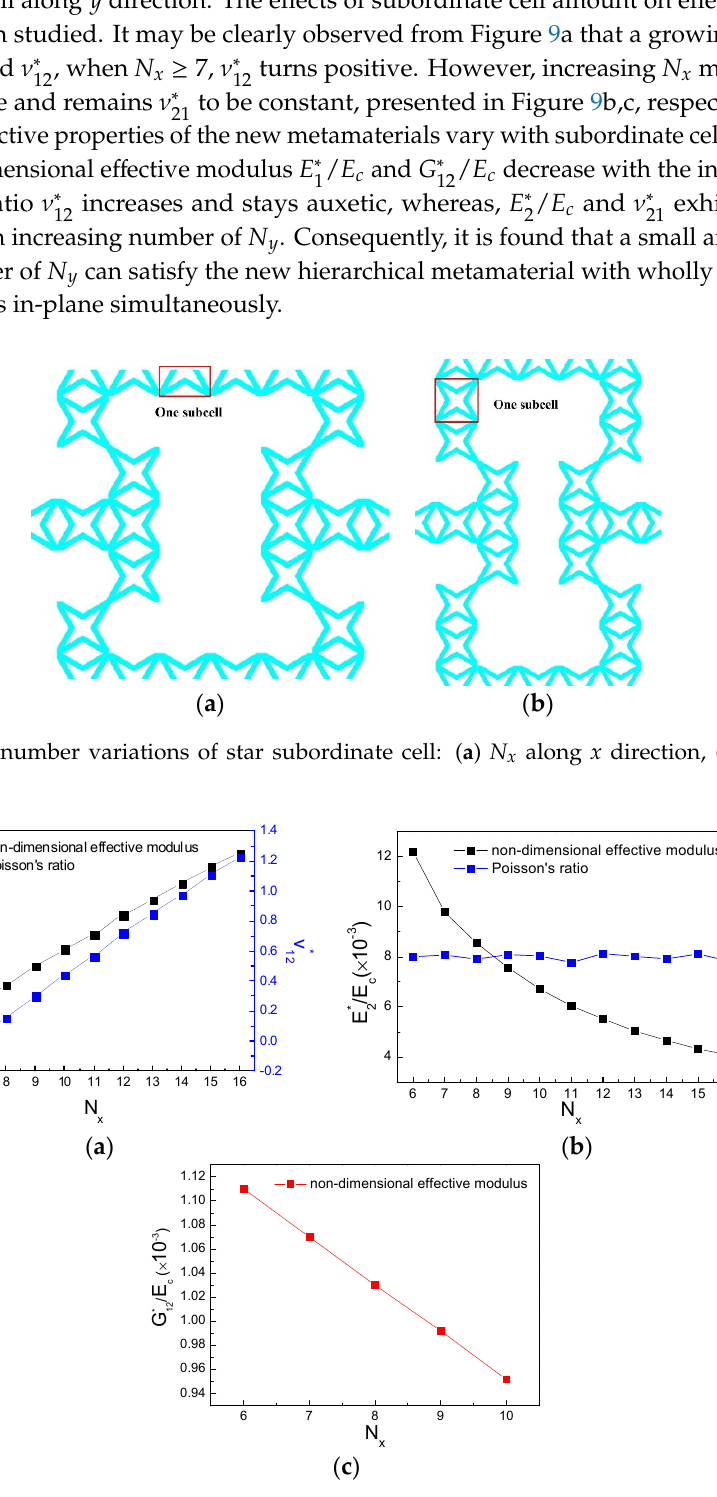
Figure 9. Variation of subordinate cell amount N x verse: ( a ) E ∗ and Poisson’s ratio ν ∗